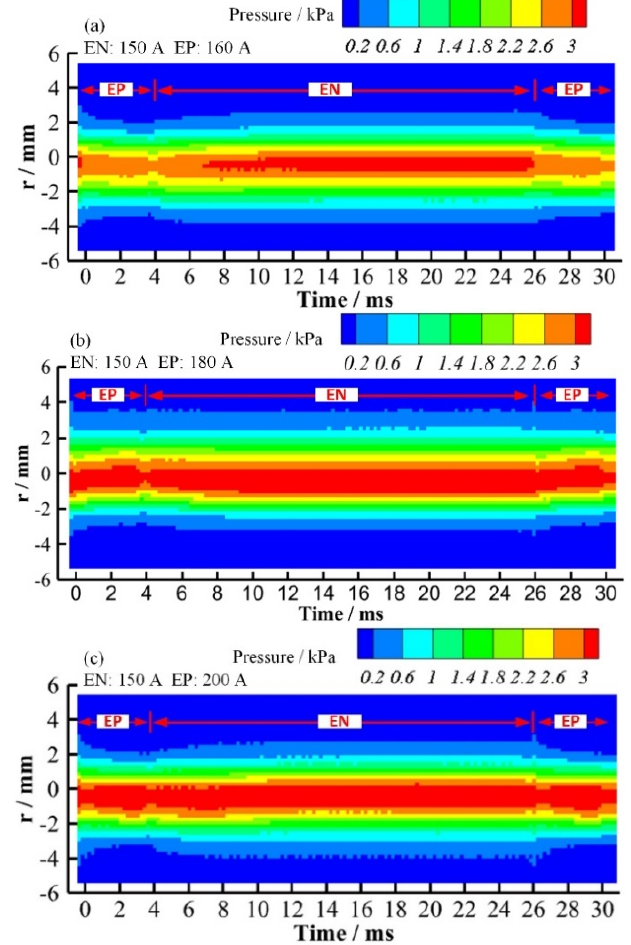
Figure 16. Radial distribution of plasma arc pressure as a function of elapsed time from the beginning of the EP phase with different EP currents. ( a ) 150 A in EN phase and 160 A in EP phase; ( b ) 150 A in EN phase and 180 A in EP phase; ( c ) 150 A in EN phase and 200 A in EP phase